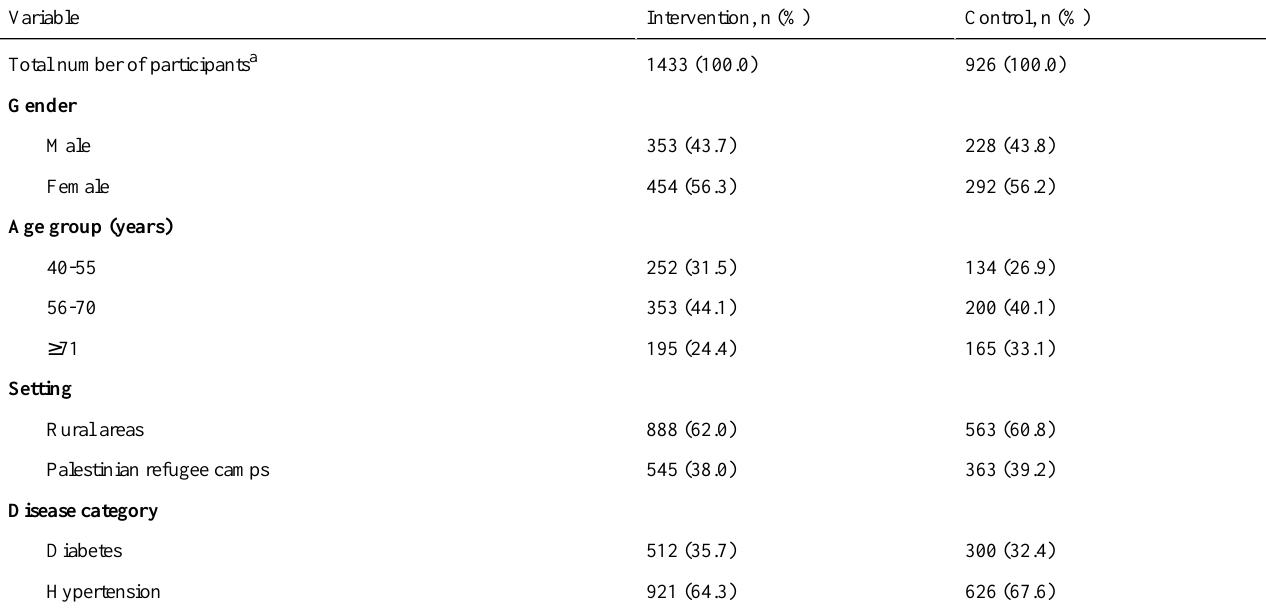
Table 2. Baseline demographic and clinical characteristics of participants by study group. No significant differences between gender, setting, and disease category across the two groups were identified using chi-square test; the difference in age groups between intervention and control at baseline is statistically significant ( P =.003). Bonferroni post-hoc test reveals that the difference is in the age group ≥ 71